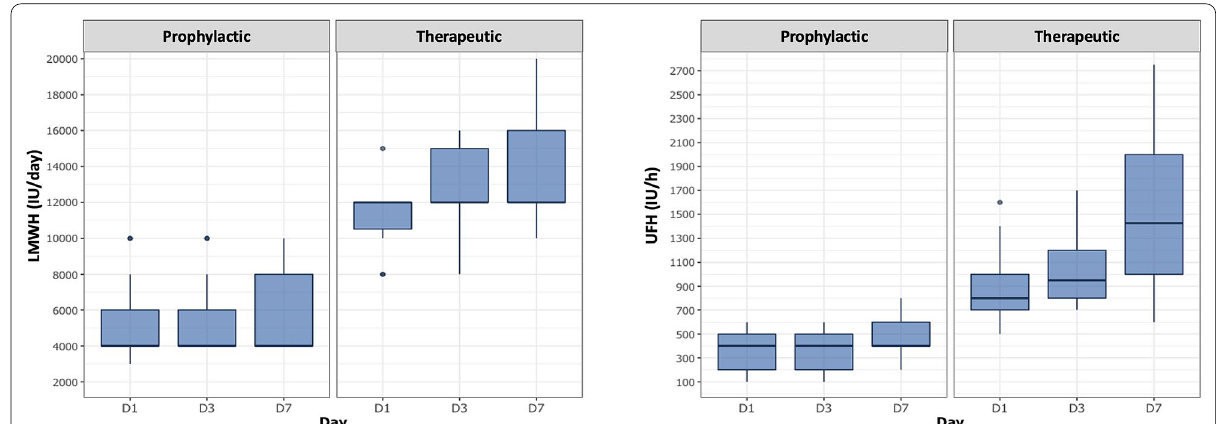
Fig. 2 Anticoagulation dosage in therapeutic and prophylactic groups at days 1, 3 and 7 after ICU admission. IU international unit, LMWH low molecular weight heparin, UFH unfractionated heparin